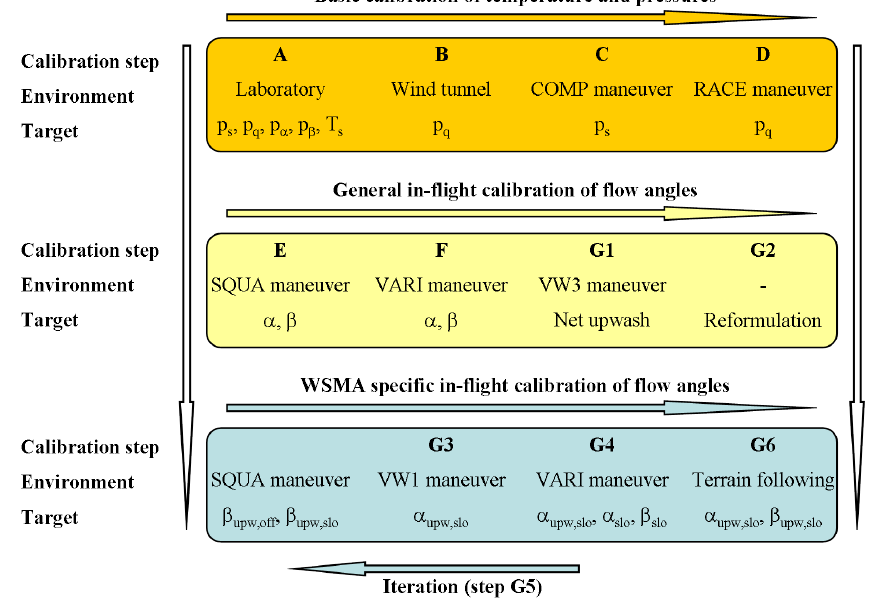
Fig. 6. Flow chart of the calibration process. The calibration steps A–G are carried out in a sequence from left to right, top to bottom. Each step results in an incrementally refined system. The iterative step G5 (blue background) comprises the three flight manoeuvres SQUA, VW1 and VARI. Within G5 the SQUA manoeuvre is not associated with an individual calibration step.